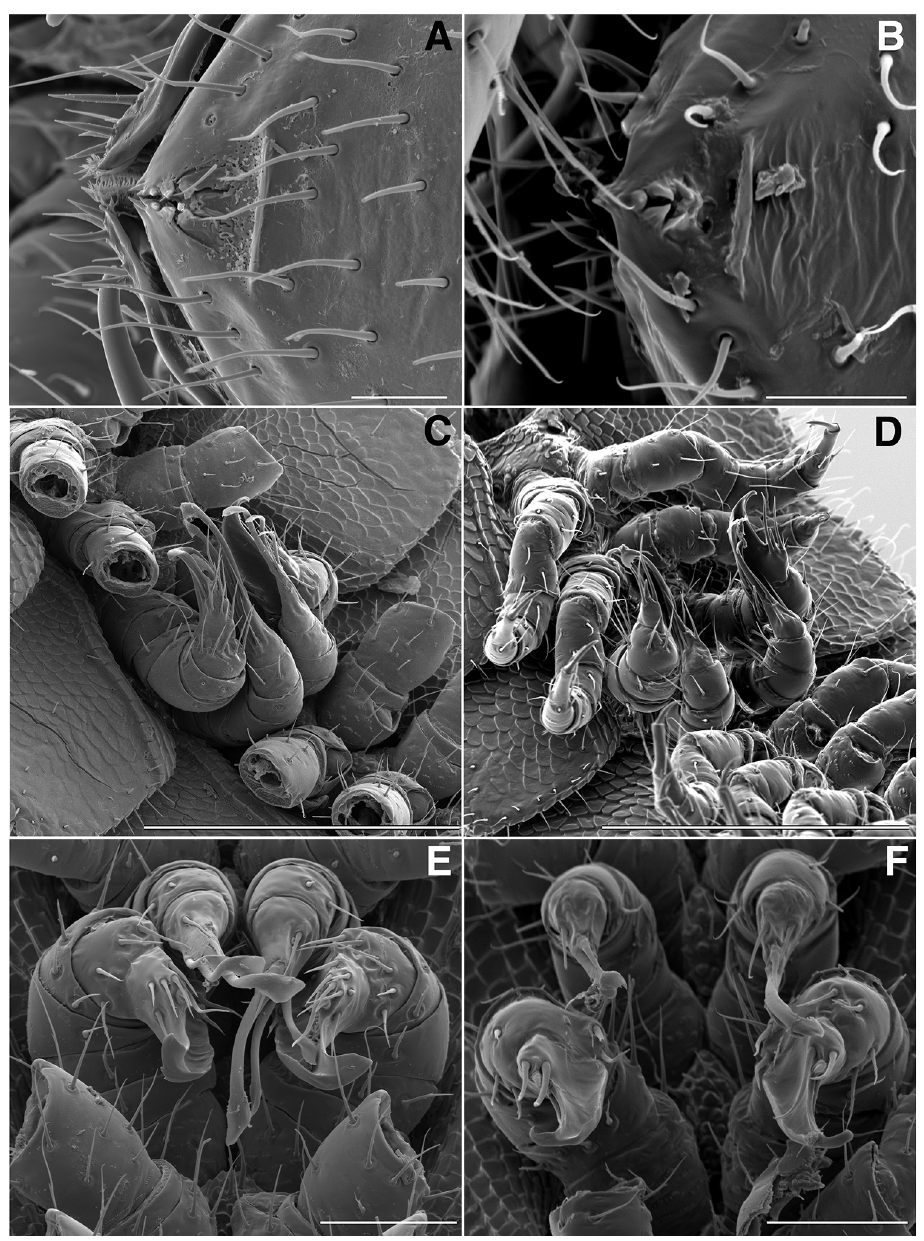
Figure 8. A Dorsal view of anterior region of head and labrum of I. tobini sp. n. (scale bar 20 µm) B the same of I. plenipes (scale bar 20 µm) C Ventrolateral (right) view of gonopods of I. tobini sp. n. (scale bar 200 µm) D the same of I. plenipes (scale bar 200 µm) E Anteroventral view of gonopods of I. tobini sp. n. (scale bar 50 µm) F the same of I. plenipes (scale bar 50 µm). (Catalog #s: I. tobini sp. n. MPE00735, I. plenipes